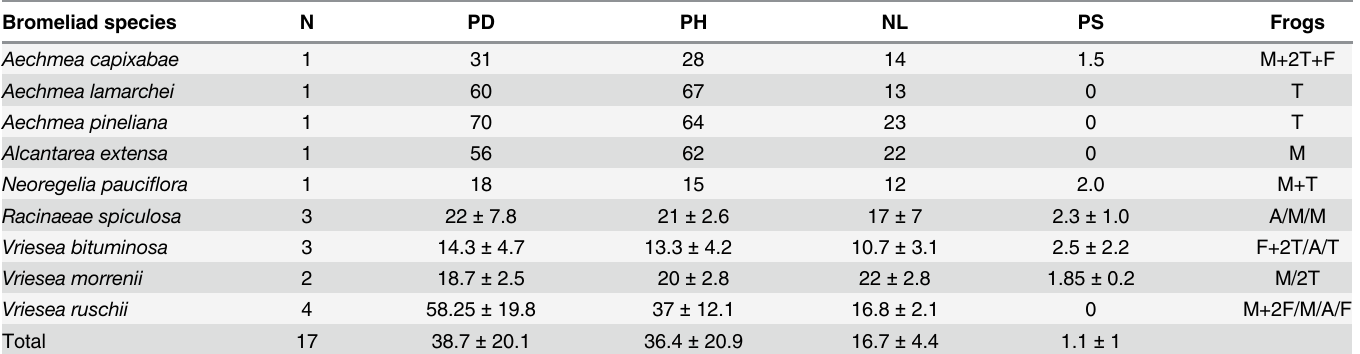
Table 2. Characteristics of bromeliad species used by Dendropsophus bromeliaceus sp. nov.. N = number of bromeliads; PD = plant diameter in cm; PH = plant height in cm; NL = number of leaves; PS = plant height from the soil in m. Frogs (sex or life stage) per bromeliad: A = adult (n = 3), M = calling male (n = 8), F = froglet (n = 4), T = tadpole (n = 10); + indicates frogs were in the same bromeliad; / indicates frogs were in different bromeliads. Mean and standard deviation are provided when